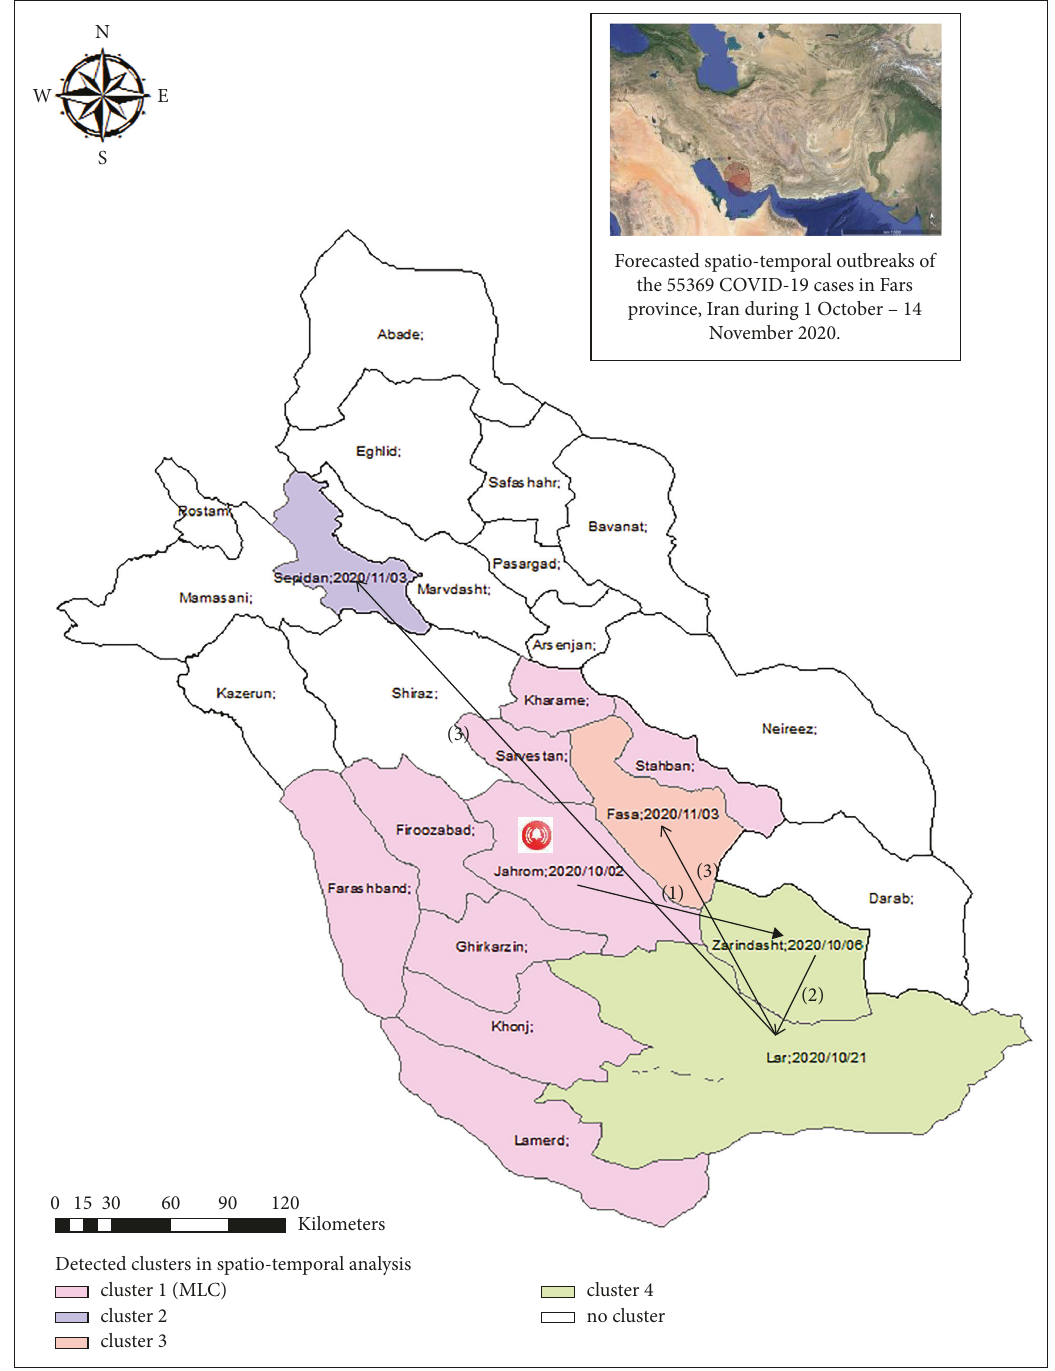
Figure 3: The progression of COVID-19 epidemic in Fars province, Iran during 1 October–14 November